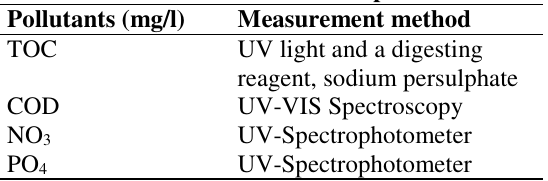
The method of measurement of the